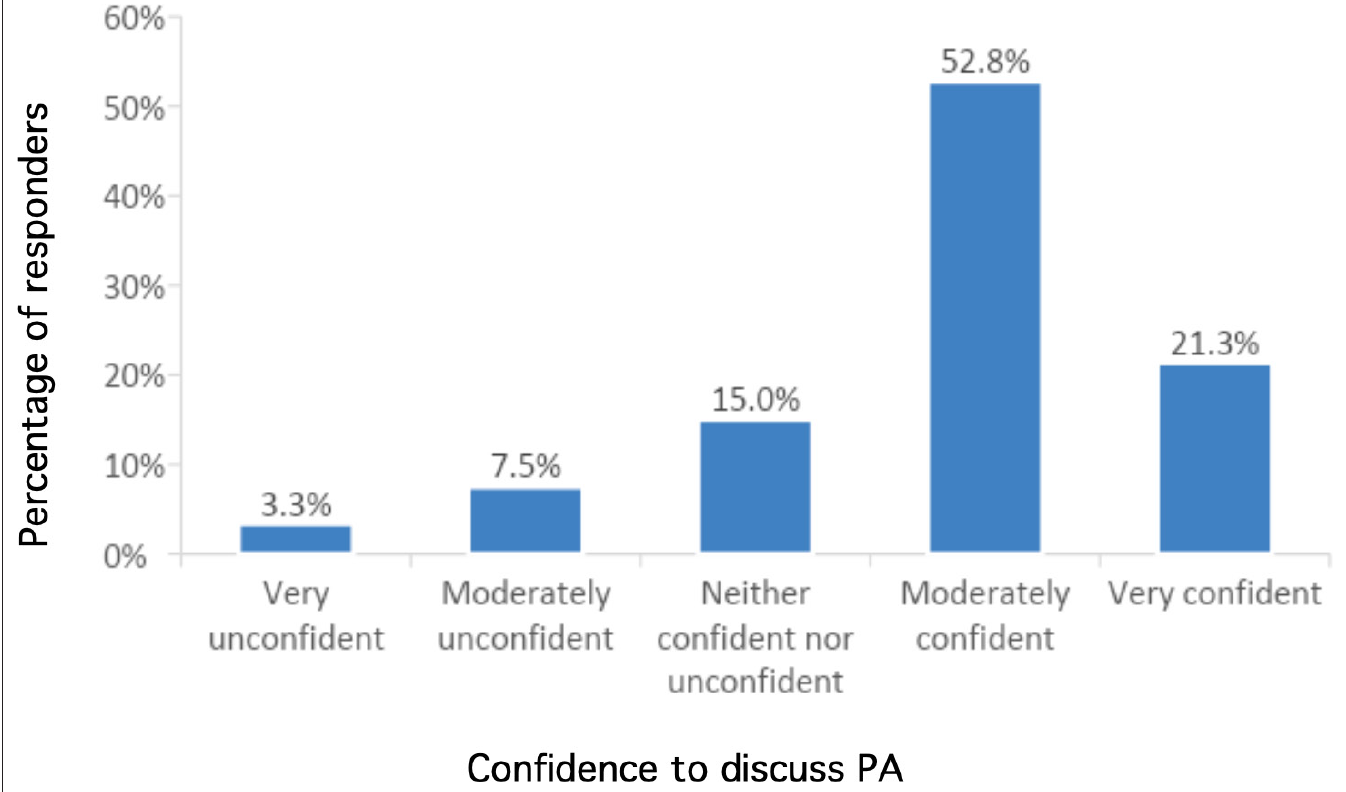
Figure 3 GPs’ confidence to discuss physical activity with their